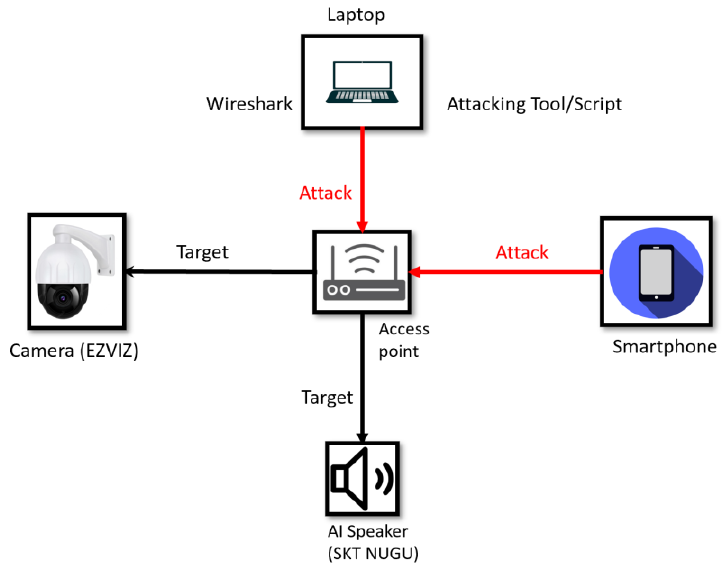
Figure 8. IoT device architecture.